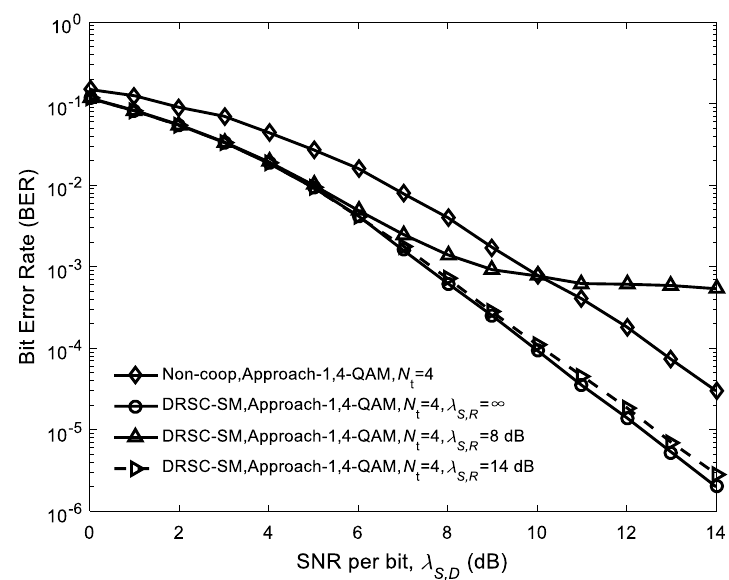
Fig. 12 Performance of DRSC-SM and noncooperative schemes (4-QAM) employing RS 1 ( 15,13 ) and RS 2 ( 15,7 ) . The solid line with upper triangle mark demonstrates the BER performance of DRSC-SM under non-ideal source-to-relay channel ( (cid:31) S , R = 8 dB). The solid line with diamond mark demonstrates the BER performance of noncooperative scheme. The dashed line with right triangle mark demonstrates the BER performance of DRSC-SM under non-ideal source-to-relay channel ( (cid:31) S , R = 14 dB). The solid line with circle mark demonstrates the BER performance of DRSC-SM under ideal source-to-relay channel ( (cid:31) S , R = ∞ )